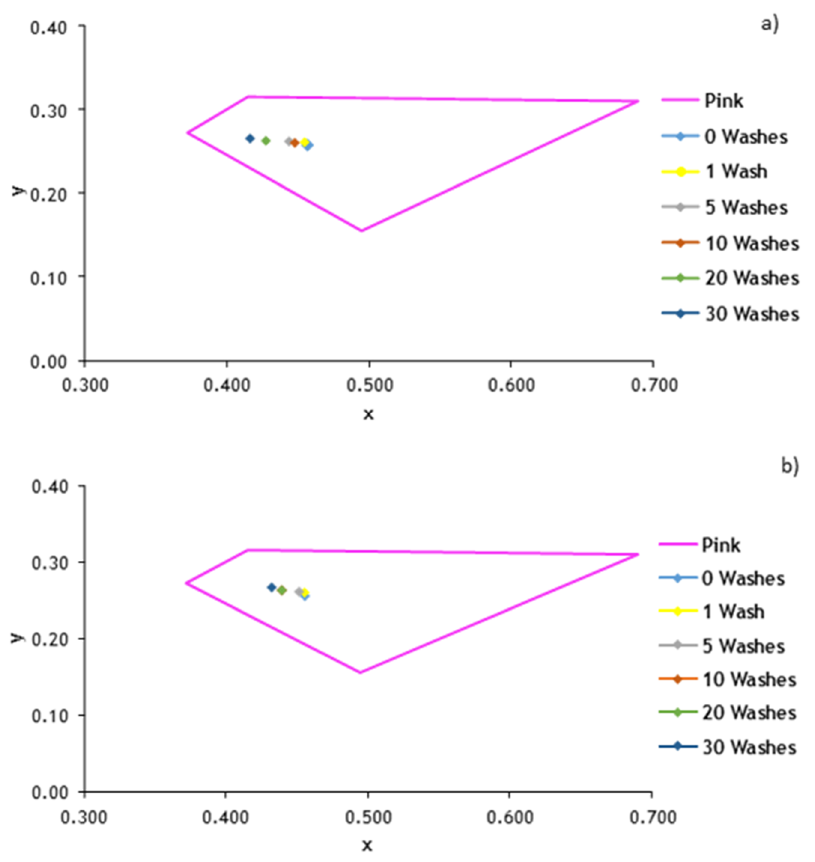
Figure 4. Chromaticity coordinates obtained for samples 2% of MG 521 pigment: ( a ) sample without cross-linker; ( b ) sample with cross-linker 1.